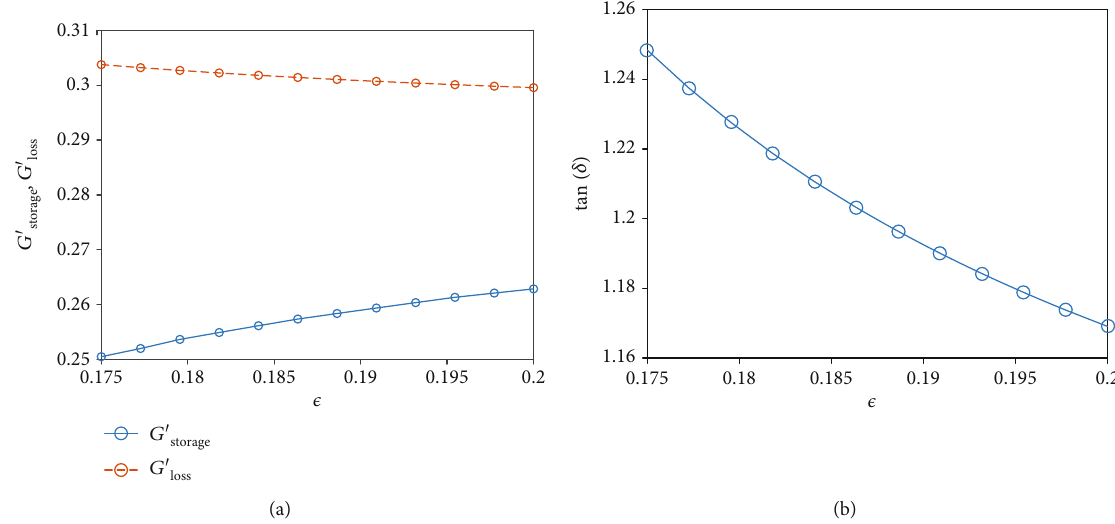
Figure 15: In fl uence of temperature, ϵ ( x -axis), parameter on (a) storage modulus, G ′ (dashed line on y -axis), and (b) loss tangent factor, tan ð δ Þ ( y -axis), at j (cid:1) ρ is inversely related to